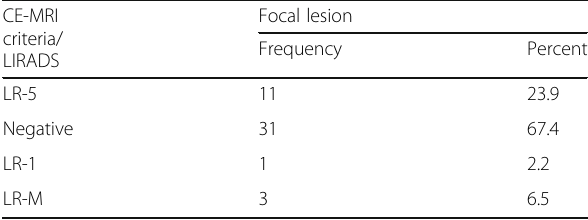
Table 2 Frequency and percentages of the focal lesions according to the LIRADS/CE-MRI